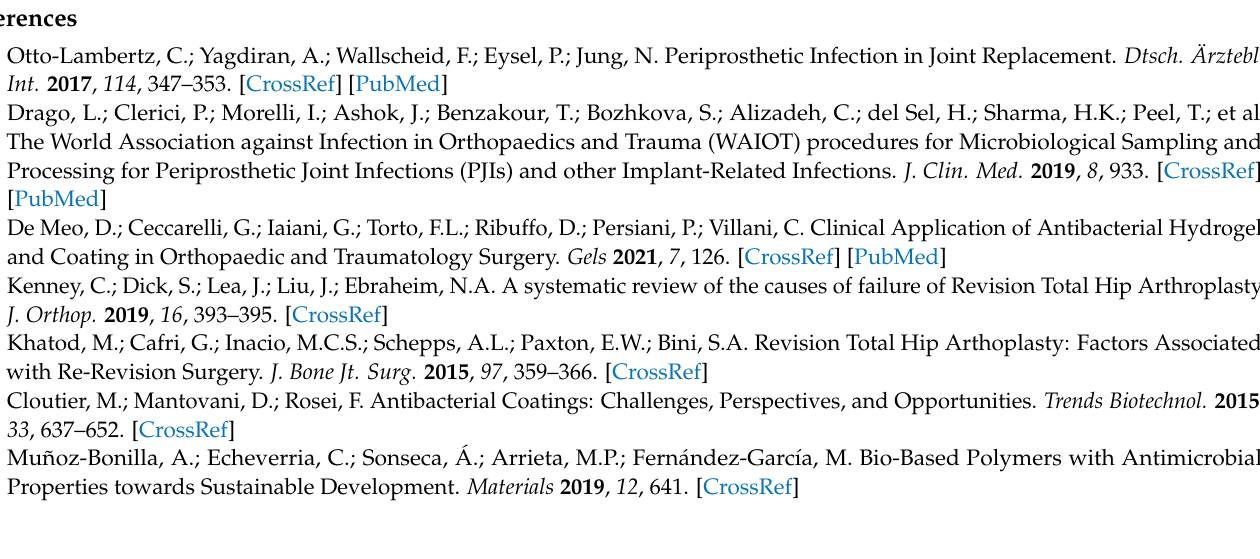
Table S2: fitting parameters of impedance data of the sample 10 gL − 1 CS/AgNPs. For comparison, the value of uncoated AISI 304L fitted with an R(CPE(R)) equivalent circuit was also reported. The mean standard deviation was